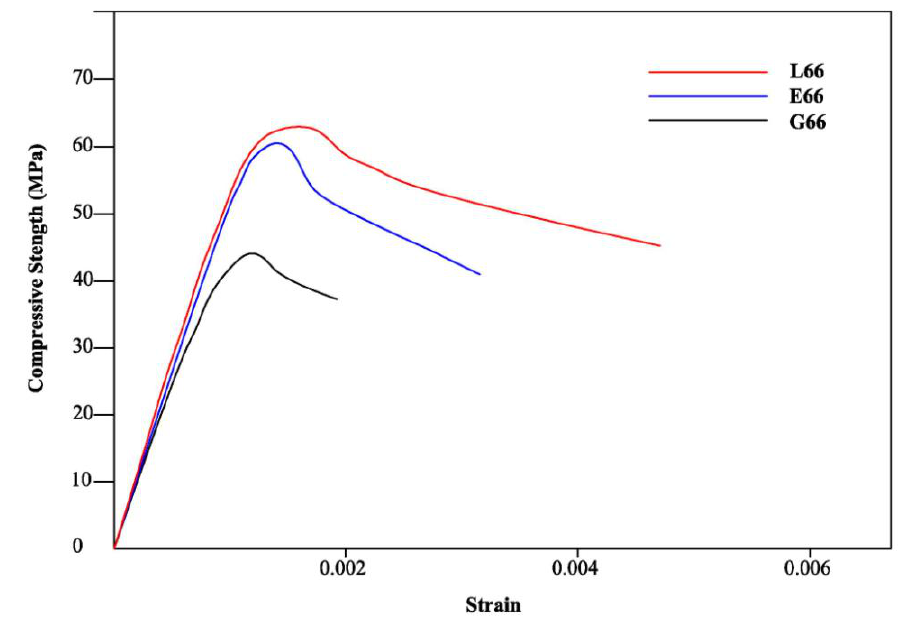
Figure 7. Stress-strain curves of G, G66, E, E66, L, L66